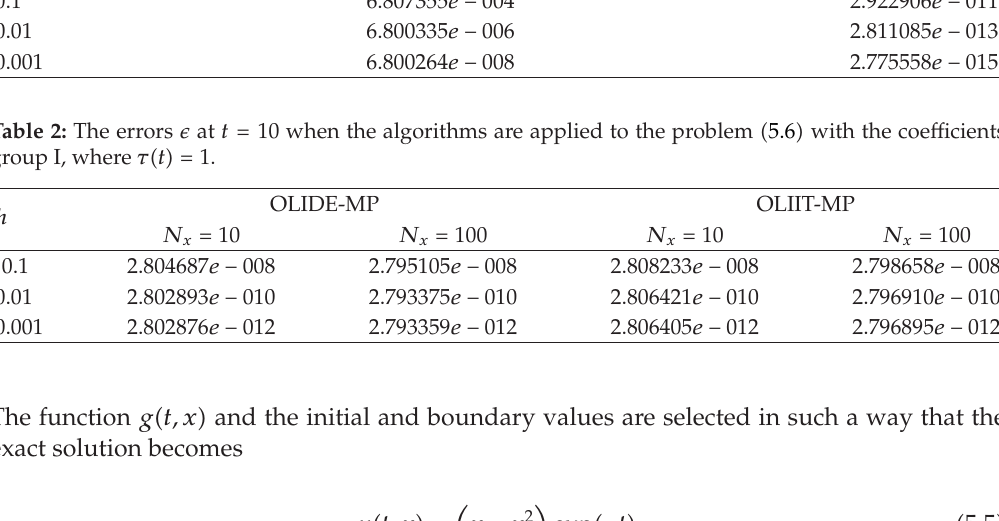
Table 1: The numerical errors at t (cid:5) 10 when the algorithm OLIDE (cid:3) I (cid:4) is applied to the problem (cid:3) 5.1 (cid:4) . h OLIDE (cid:3) I (cid:4) -MP OLIDE (cid:3) I (cid:4) -BDF2 0 . 1